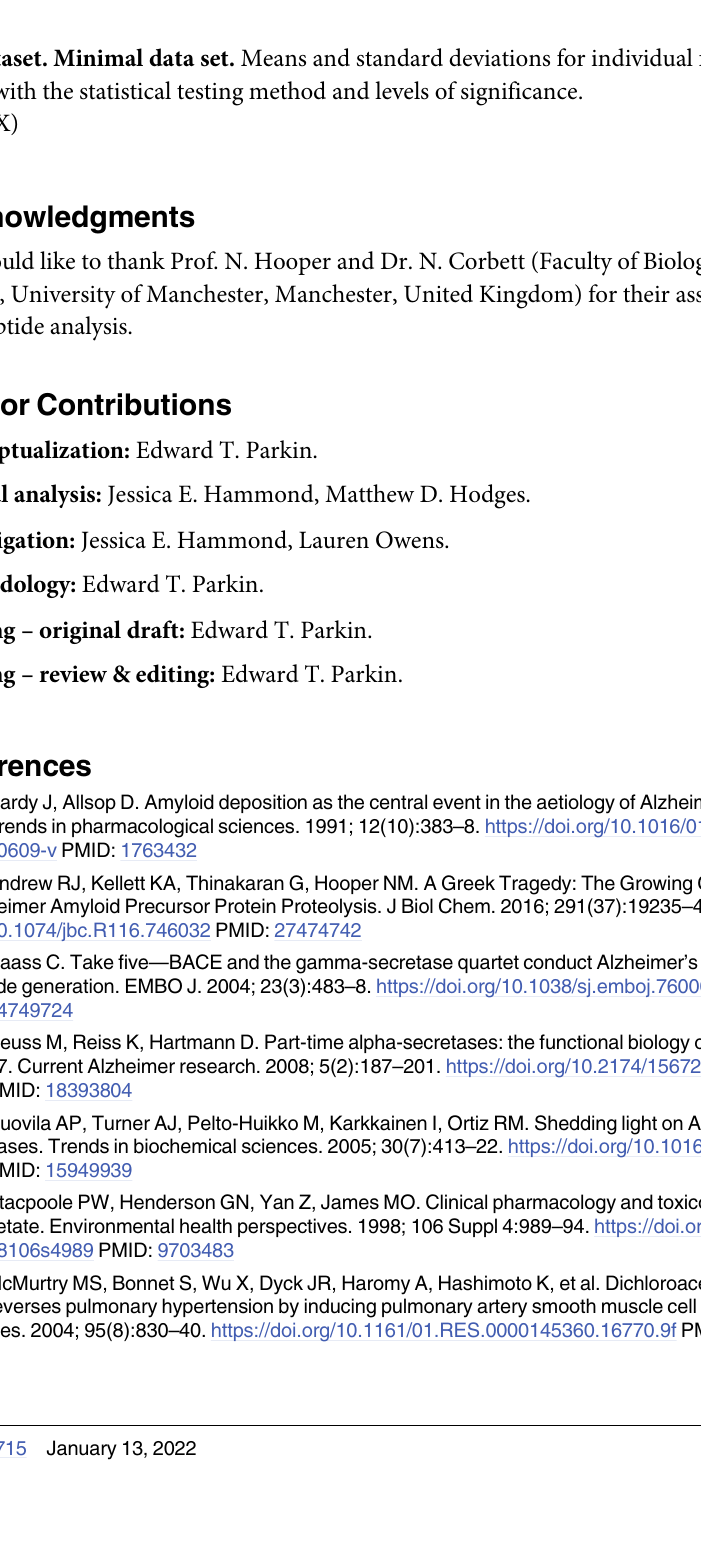
samples were immunoblotted with anti-APP 6E10 antibody to detect sAPP α . Multiple immu- noblots were quantified and results were expressed relative to control values. All results are means ± S.D. (n = 3). � = significant at p < 0.05; �� = significant at p < 0.01; ��� = significant at p < 0.005. S1 Raw images. Original immunoblot images. Whole blot images are shown from which the lanes marked ‘X’ are excluded from cropped images shown in figures. S1 Dataset. Minimal data set. Means and standard deviations for individual figure panels along with the statistical testing method and levels of